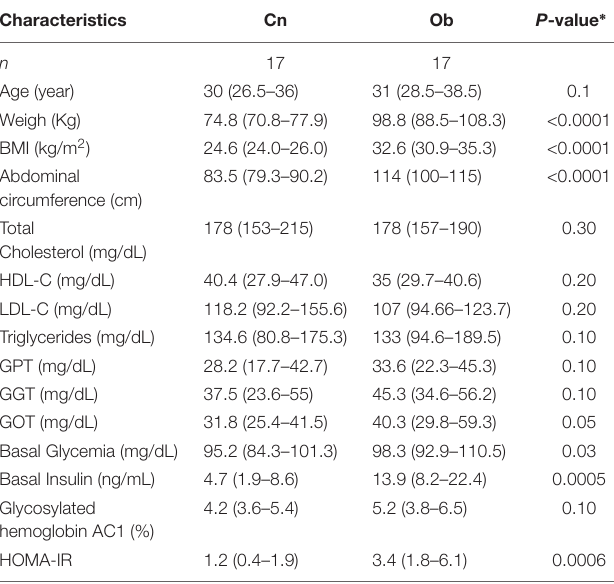
TABLE 3 | Parameters of iron nutrition and inflammation.